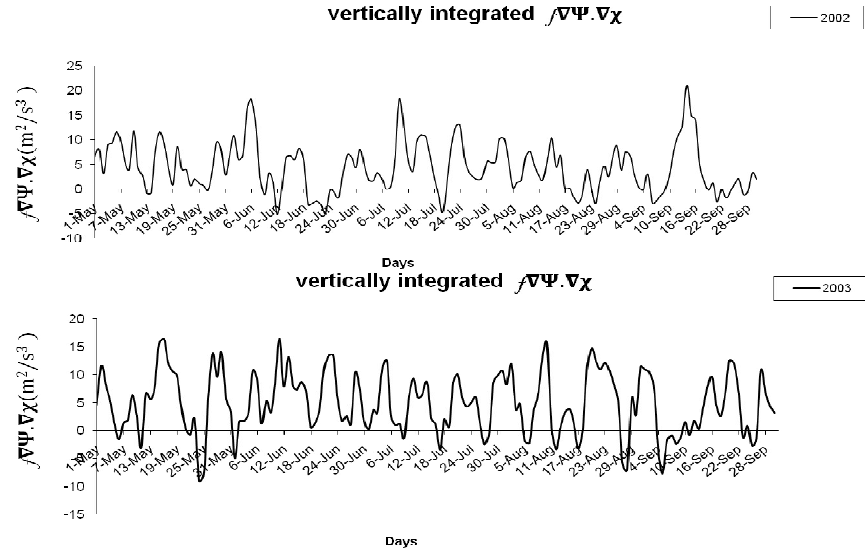
Fig. 8. Vertically Integrated (1000–100hPa) f ∇ ψ ·∇ χ from 1 May–30 September during 2002 and 2003 over the domain 30 ◦ S–40 ◦ N and 30 ◦ E–150 ◦ E.